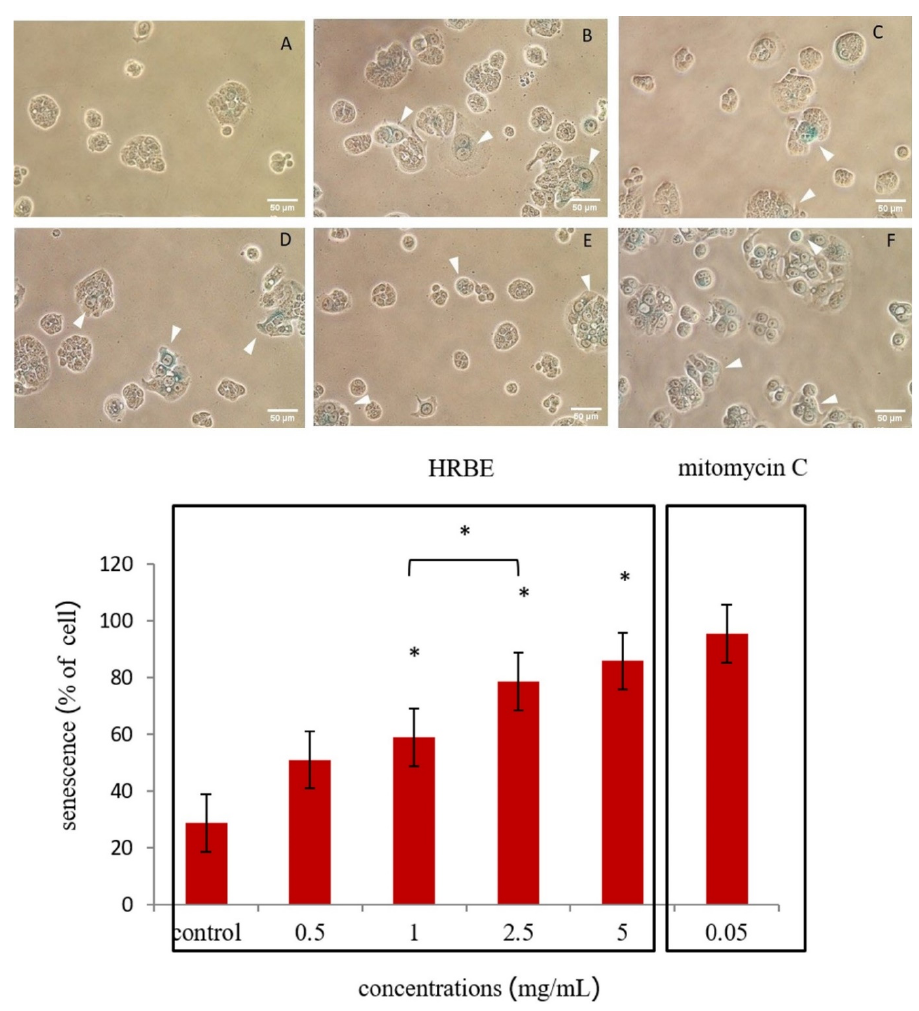
Figure 3. Cellular senescence inducing effect of HRBE on HT-29 cells after being treated with 0 mg/mL, considered as negative control ( A ), 0.5 mg/mL ( B ), 1 mg/mL ( C ), 2.5 mg/mL ( D ) and 5 mg/mL ( E ) for 24 h compared to 0.05 mg/mL mitomycin C treatment, considered as the positive control ( F ). The blue stained cells with flattened and enlarged cell morphology represent the cellular senescence status indicated by the white arrowheads. Data are represented by the mean ± SD. Statistical analysis was performed using student’s t -test comparing each concentration with the control group (0 mg/mL) (*, p ≤ 0.05).